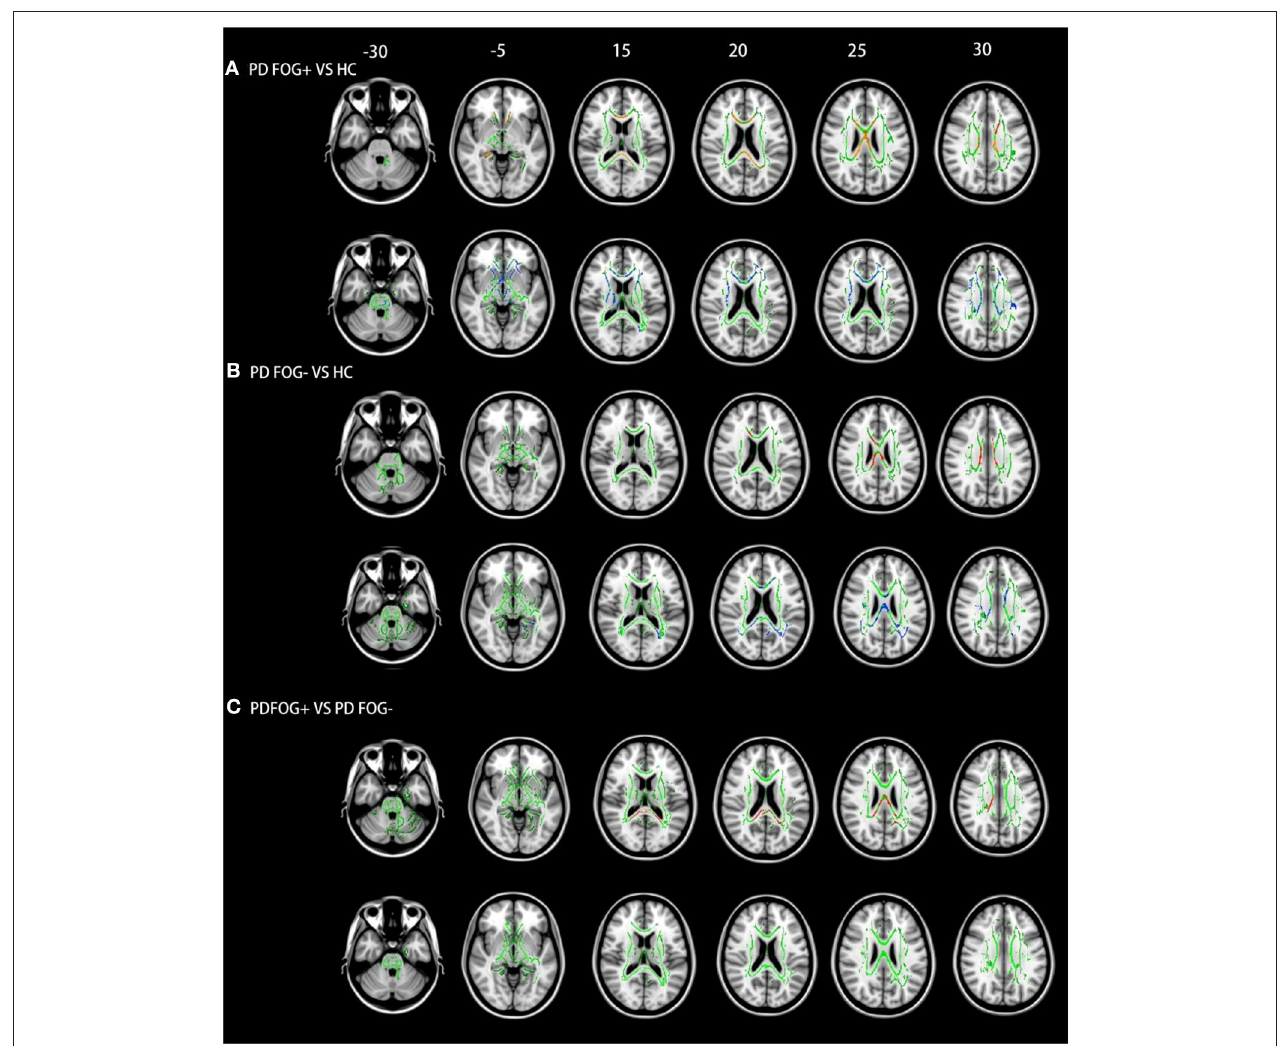
FIGURE 2 | TBSS results in the three groups. (A) PD FOG + vs. HC. (B) PD FOG– vs. HC. (C) PD FOG + vs. PD FOG–. Red and blue represent regions with reduced FA and increased MD, respectively. The WM skeleton is shown in green. Results are shown at P < 0.05 (family-wise